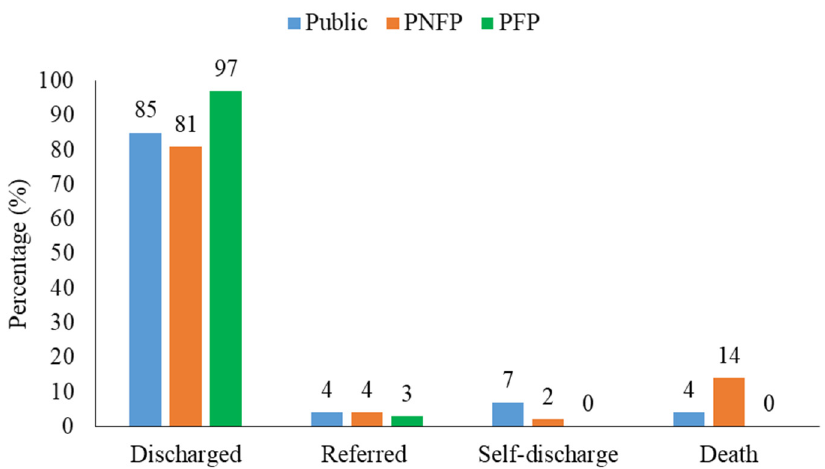
Figure 5. Patient treatment outcome proportions based on health facility category.